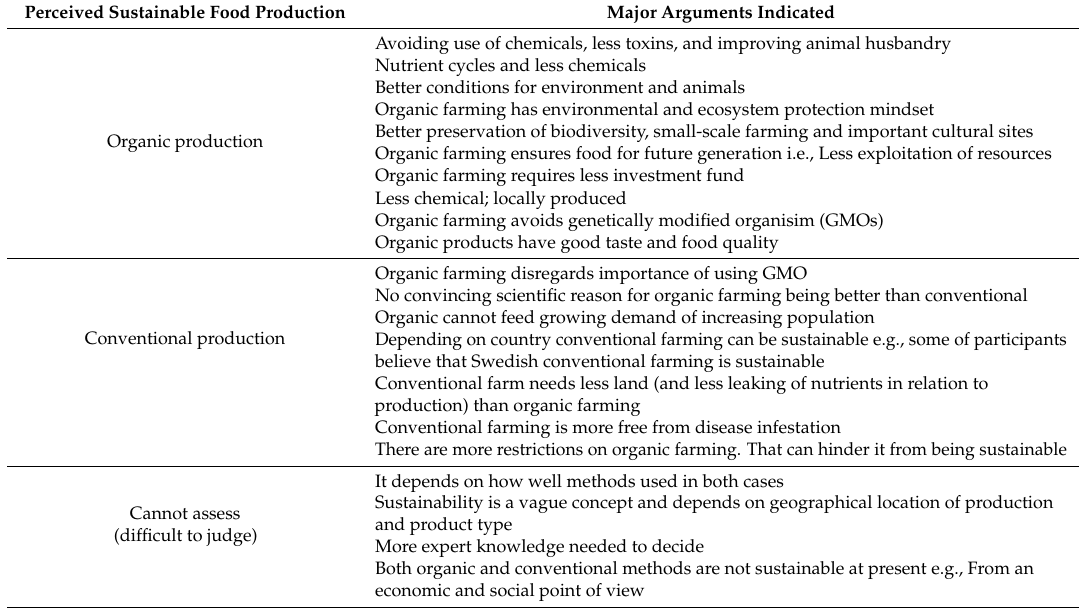
Table 3. Arguments behind the responses on perception on sustainable food production.